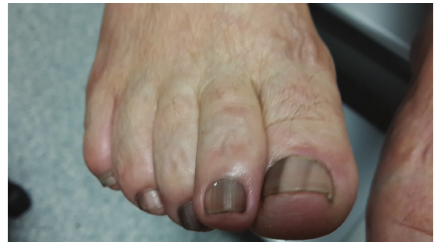
Figure 2: Melanonychia of the lower extremity